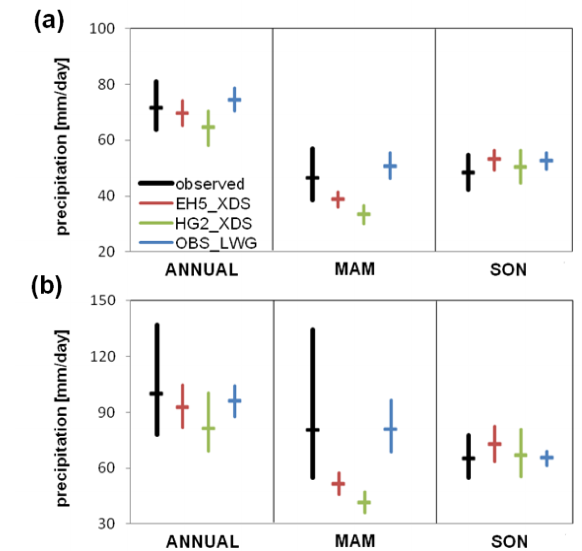
(1971–2000) and reference simulations (EH5 XDS, HG2 XDS, OBS LWG; 1971–2000). Vertical lines indicate 90% bootstrap con- fidence intervals. 24-h precipitation events averaged over the Lech catchment are